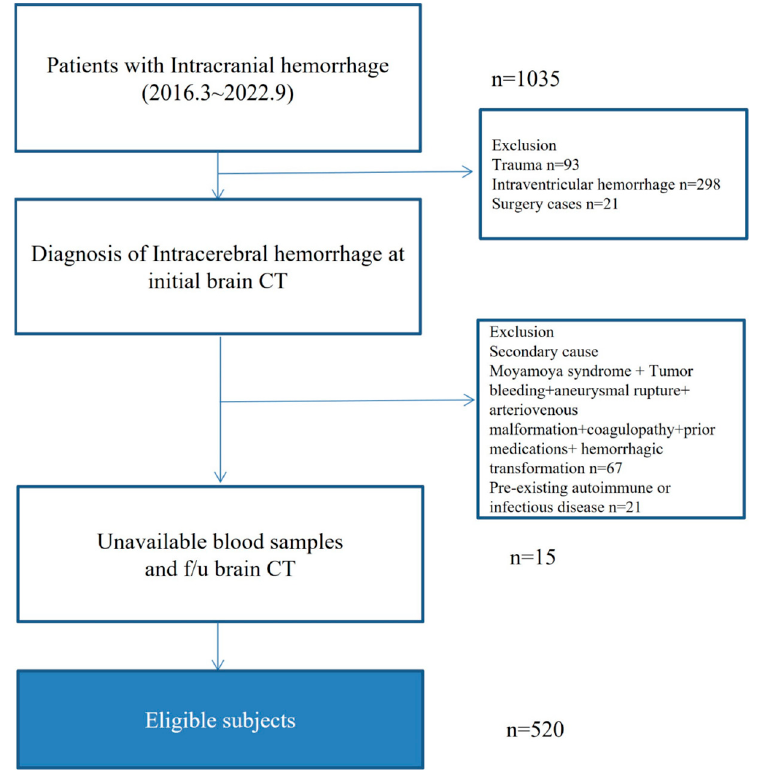
Figure 1. Flow chart of this study.